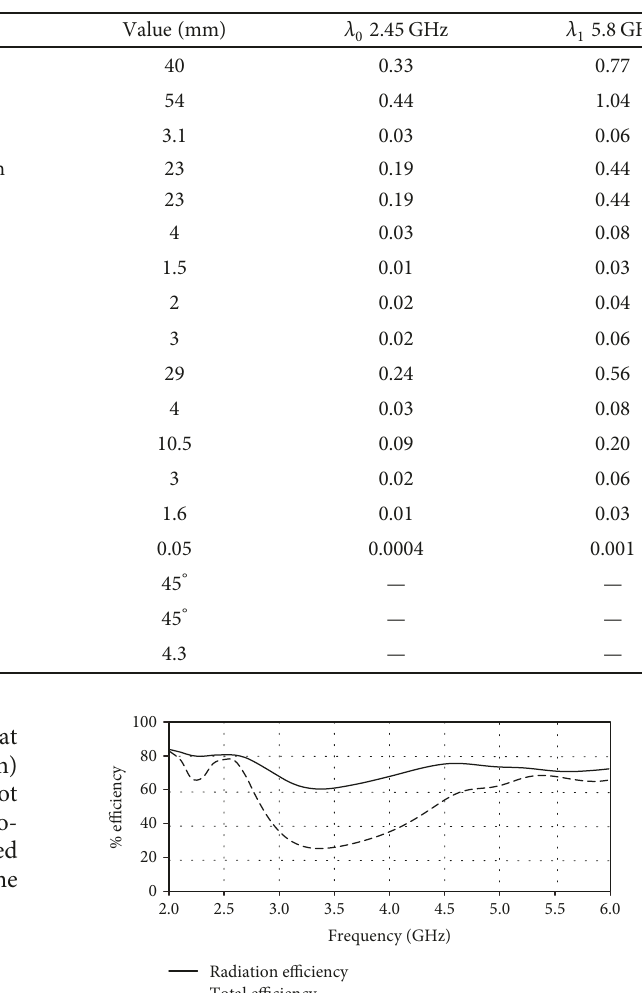
Figure 10: The left hand and right hand circular polarization radiation patterns of antenna A, antenna B, and antenna C: (a) 2.45GHz; (b) 5.8GHz. Table 1: The optimal parameters of the proposed WLAN-enabled dual-frequency antenna.